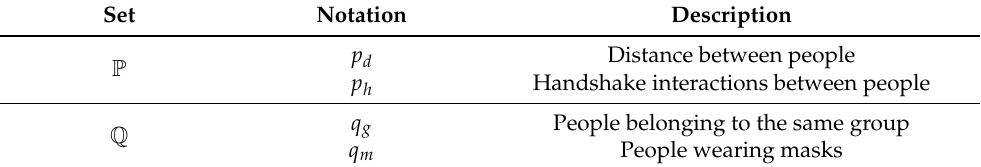
Table 2. Parameters used in threat quantification. Set Notation Description P p